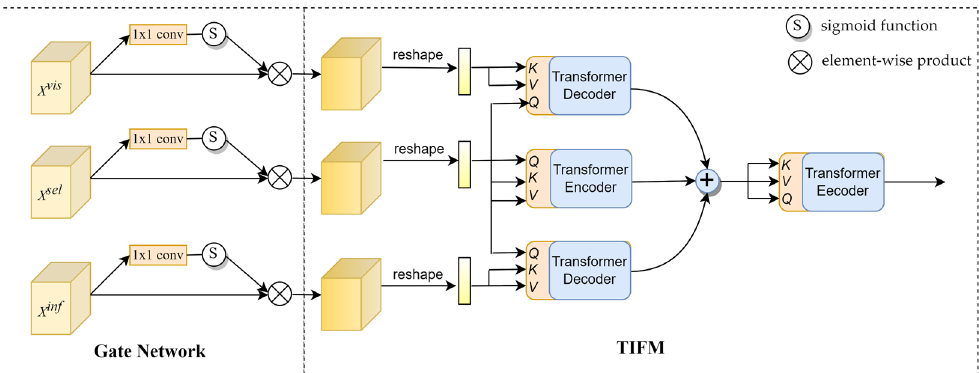
Figure 5. Speci fi c structure of the Gate Network and TIFM.